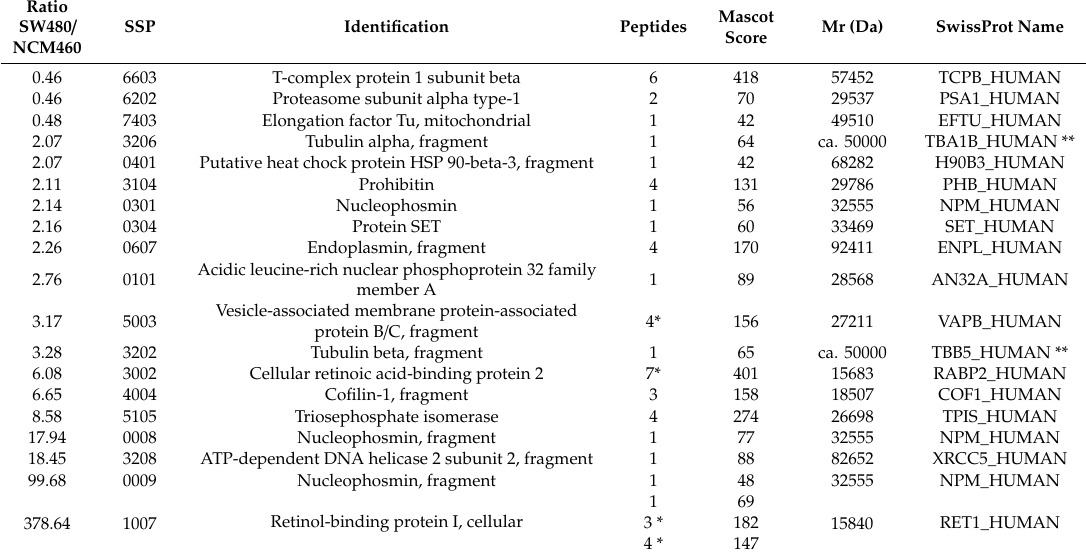
* Identified from Coomassie stained gels. The rest is identified from silver stained gels. ** Several variants.